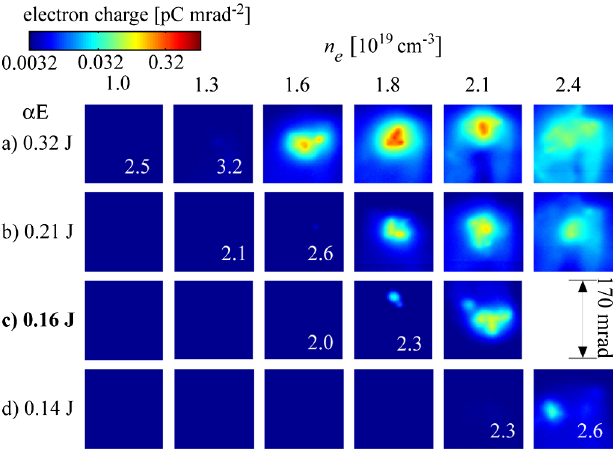
FIG. 1. Electron beam profiles for various plasma densities for different values of the amount of laser energy within the FWHM of the focal spot. (a), (b), and (d) kept the total laser energy constant but varied (cid:1) whereas (c) reduced the laser energy. Each panel is an average of five shots and is displayed on a logarithmic color